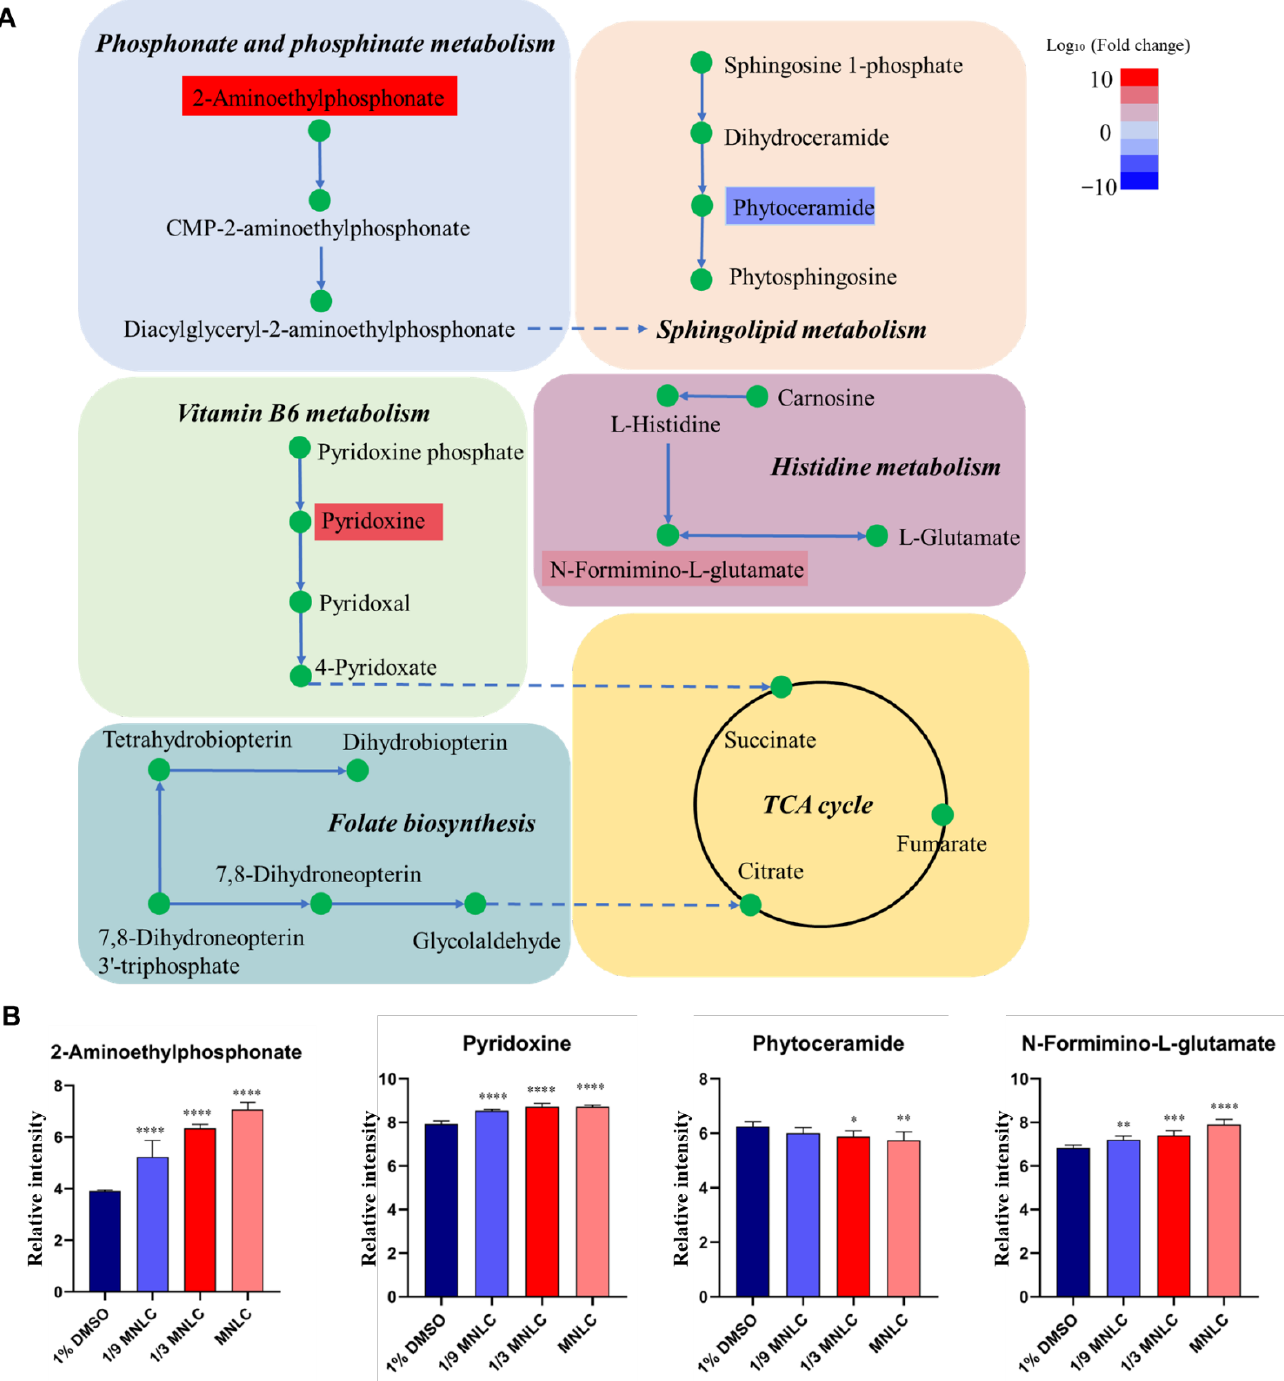
Figure 7. ( A ) Perturbed pathways and fluctuating metabolites in zebrafish embryos induced by scopoletin exposure. ( B ) The relative concentration level of differential metabolites in the perturbed pathways. The data were log 10 transformed and asterisks denote statistical significance according to a multiple group comparison of ANOVA (only significative results of exposed groups vs. solvent control are illustrated); * p -value < 0.05, ** p -value < 0.01, *** p -value < 0.001, **** p -value < 0.0001.